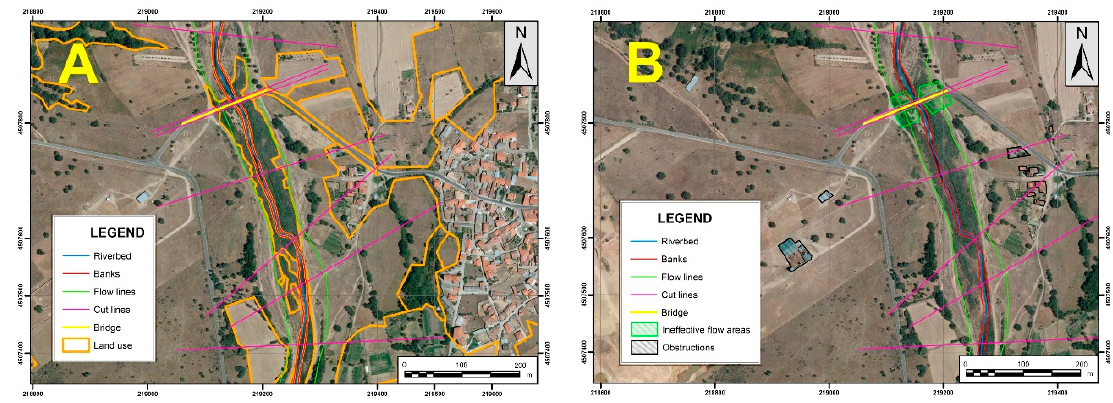
Figure 6. Digitalization of ( A ) land use; ( B ) the ineffective flow areas and obstructions.